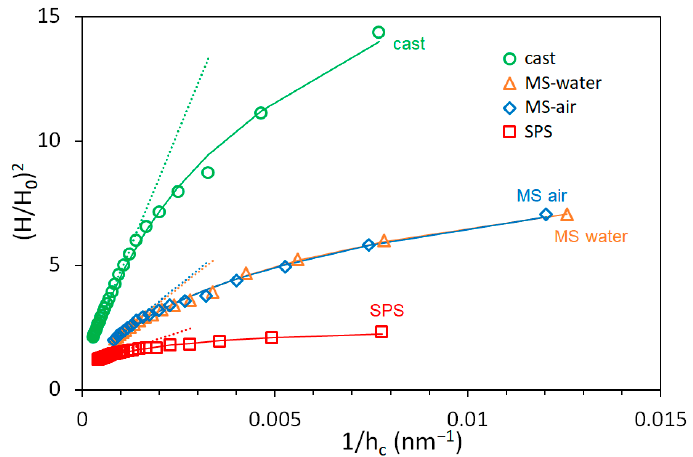
Figure 7. Normalized H 2 vs. 1/ h plot of CoCrFeMnNi samples.